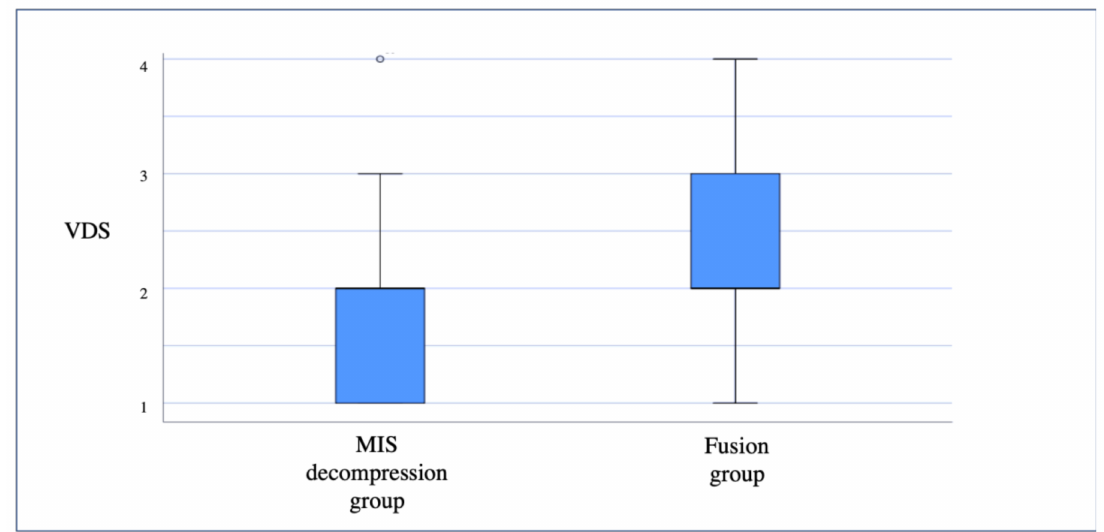
Figure 2. Distribution of the reported Verbal Descriptor Scales (VDS) for leg pain for the MIS decompression and fusion